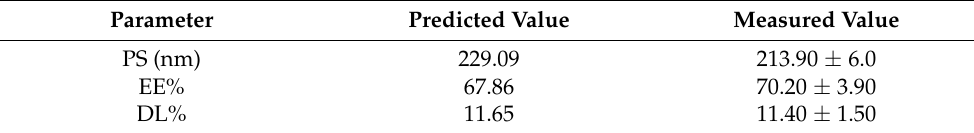
Table 3. Predicted value and observed value of optimal preparation process of CUR@CS-NP.